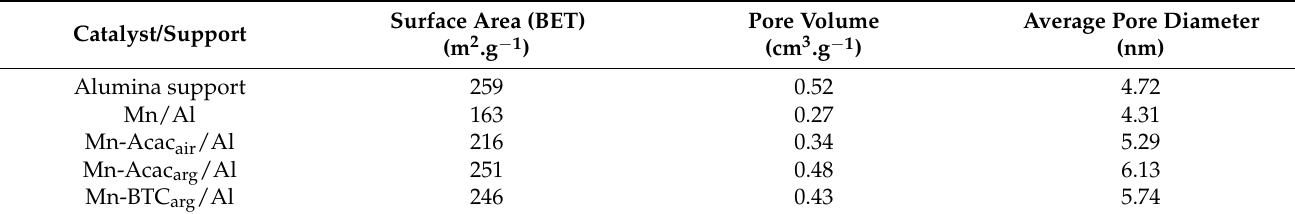
Table 1. BET surface analyses of the support and